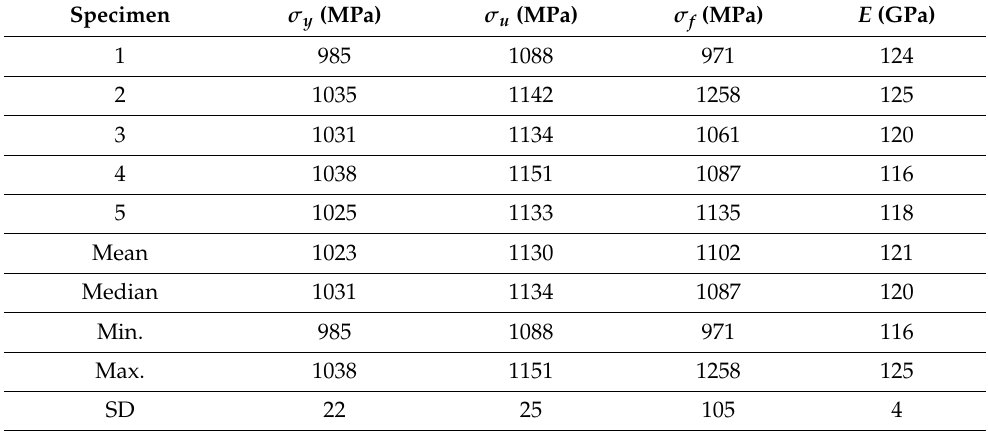
Table 3. Mechanical properties for the tensile test specimens of the Ti–6Al–4V alloy obtained by EBM. Specimen σ y (MPa) σ u (MPa) σ f